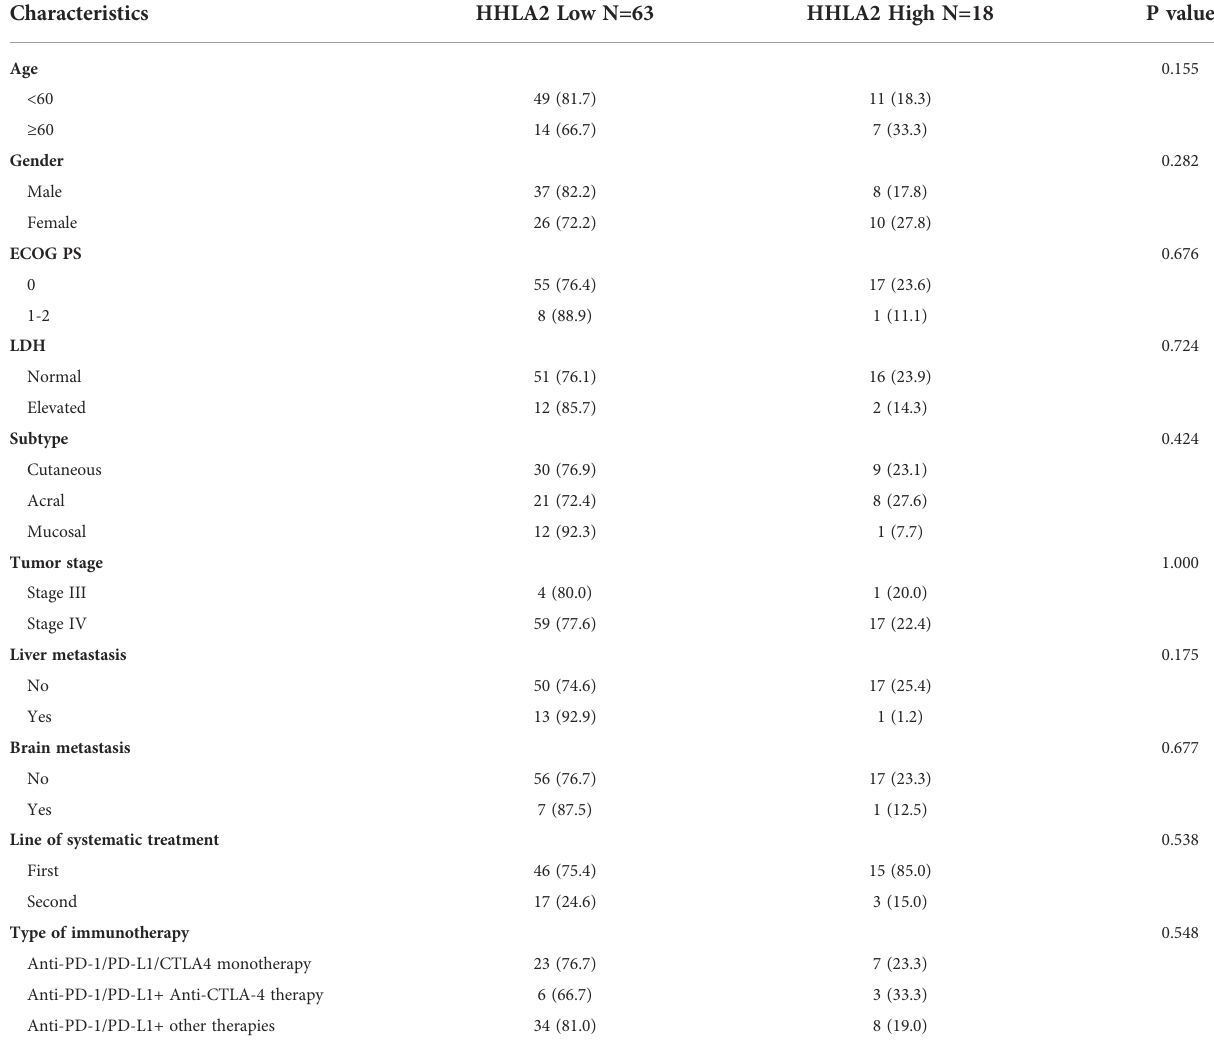
TABLE 1 Clinicopathological characteristics of patients enrolled in our